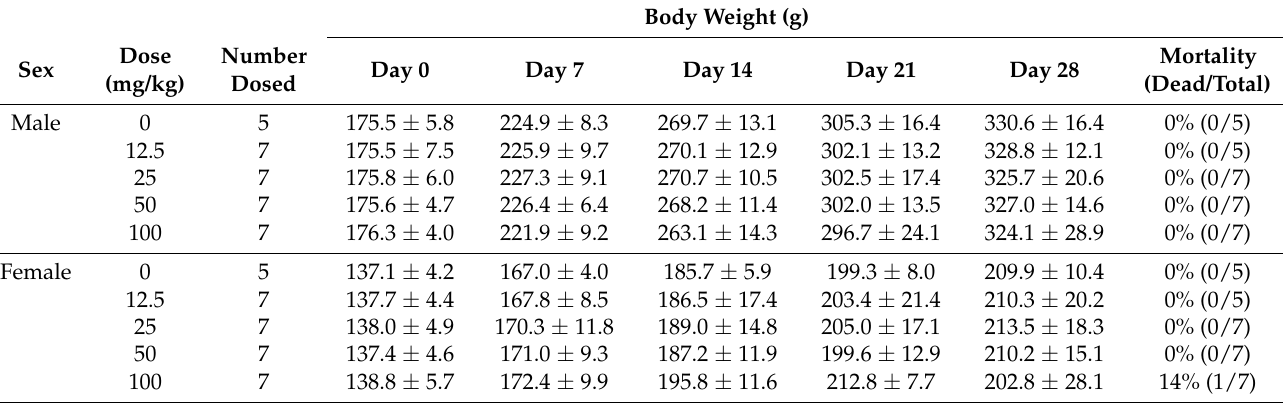
Table 2. Body weight changes for the 28-day repeated oral toxicity